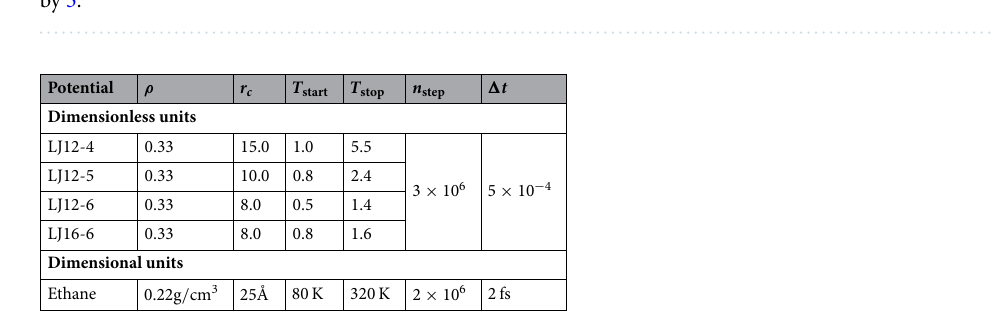
Figure 4. Reduced particle mobility ( a ) and diffusion ( b ) on the liquid branch of the gas-liquid binodal versus the reduced temperature for generalised Lennard–Jones systems: Symbols are MD results and solid lines are fits by 5.